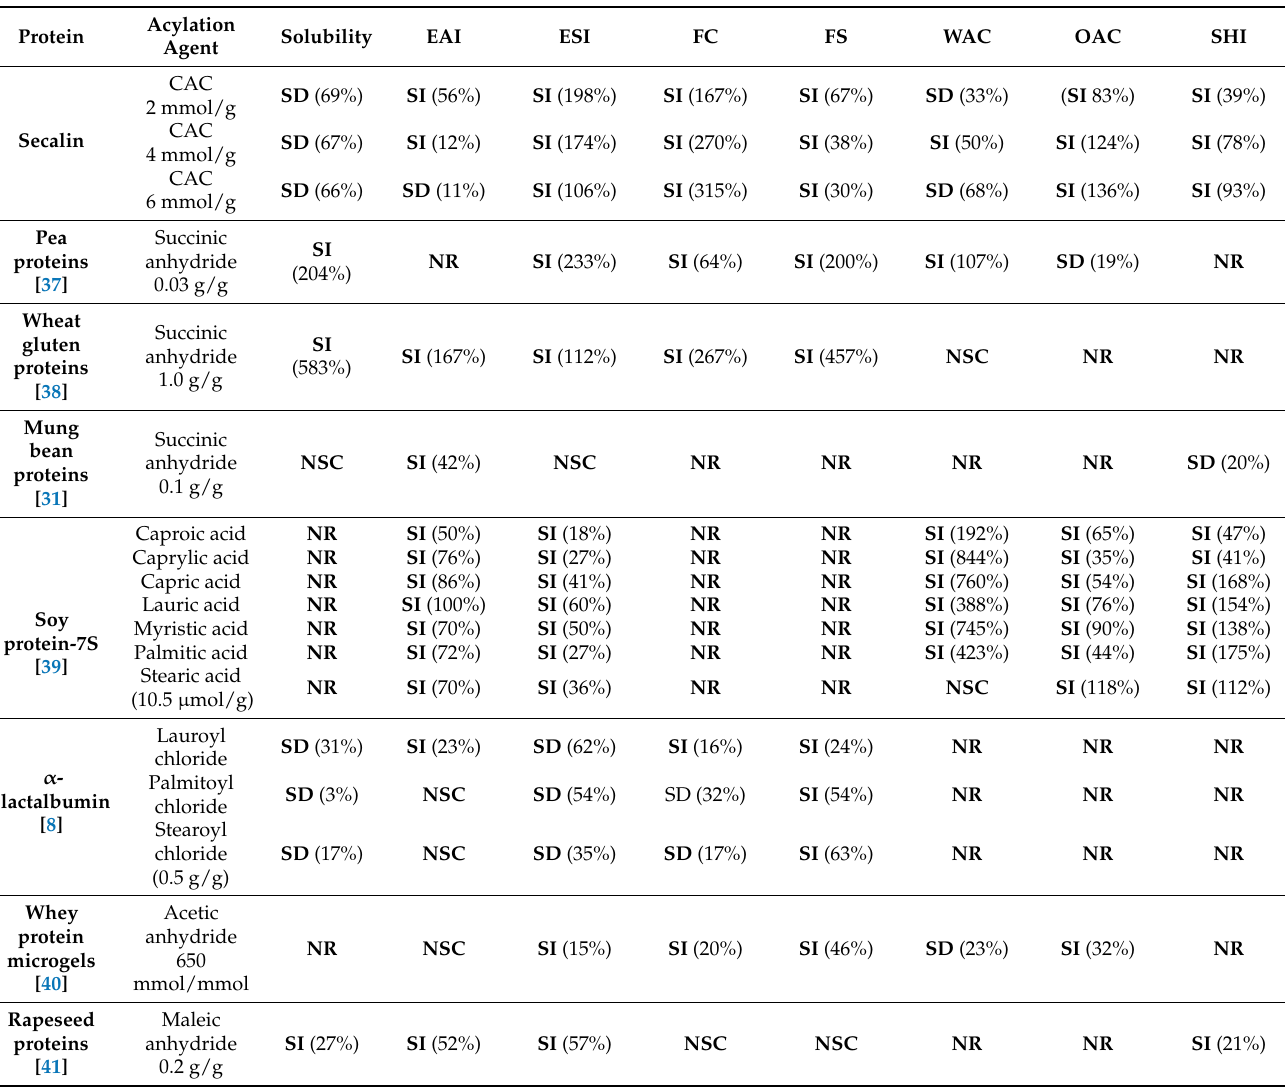
Table 3. Effects of lipophilization of different proteins of food interest on their functional properties *. Protein